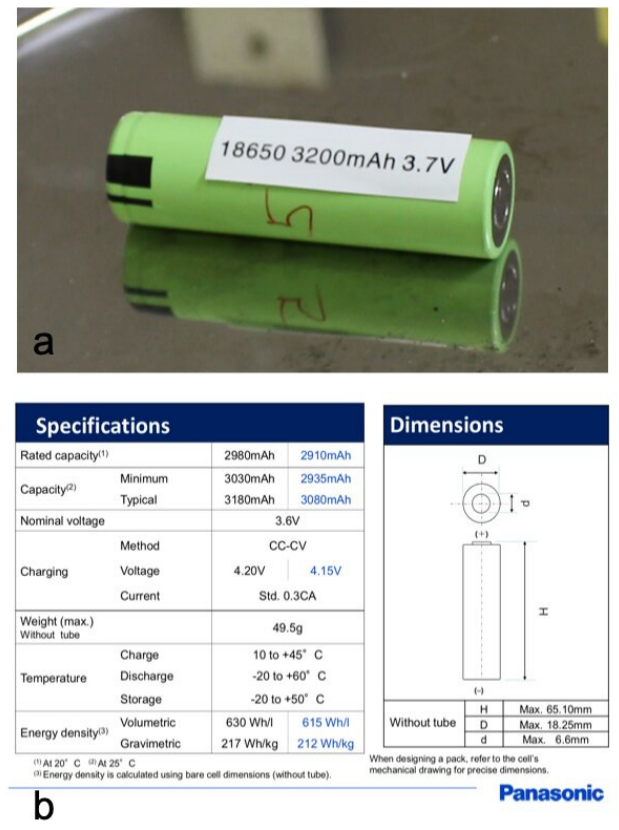
Figure 1. ( a ) Cell NCA 18650 and ( b ) its technical specifications [39].